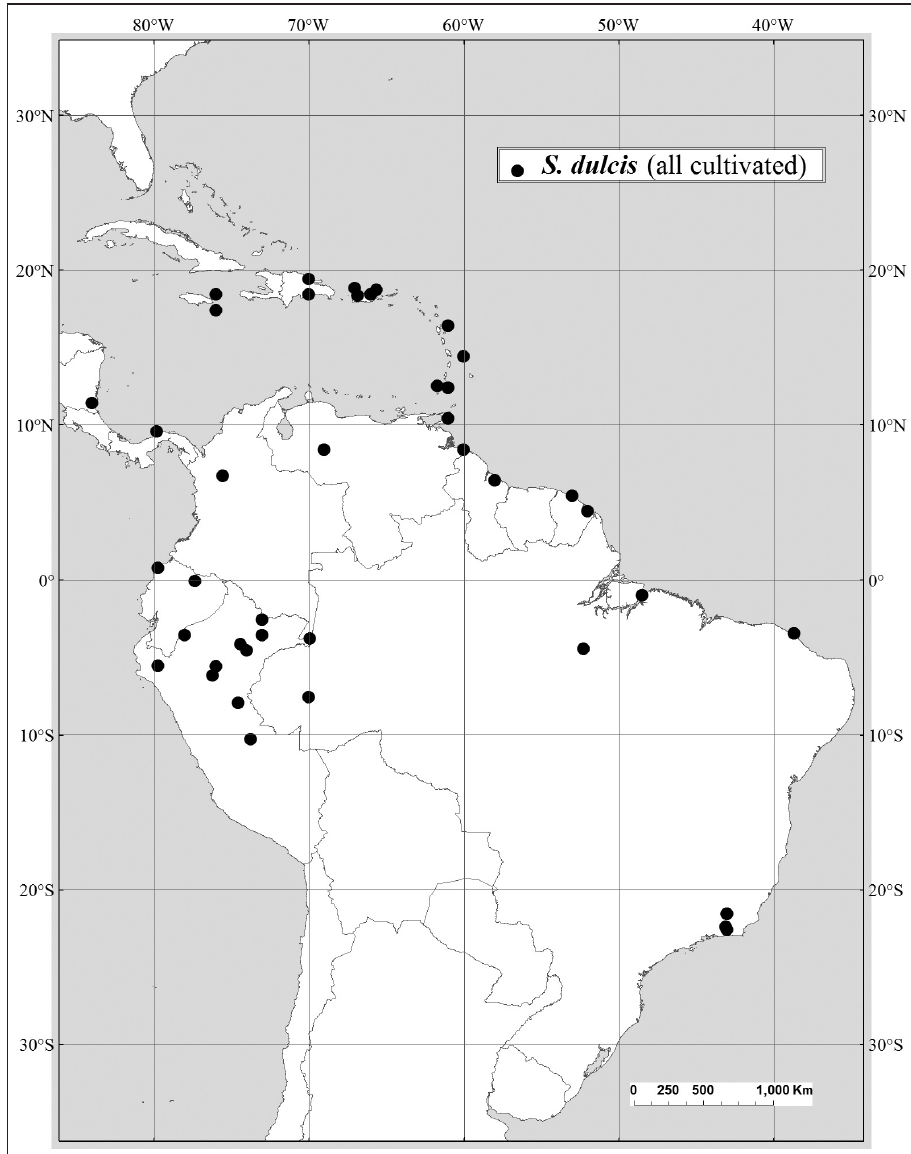
Figure 20. Distribution of Spondias